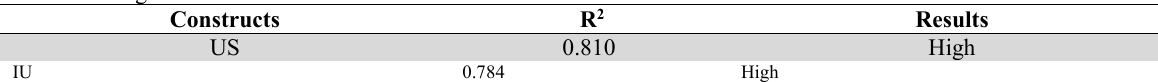
R 2 of the endogenous latent variables